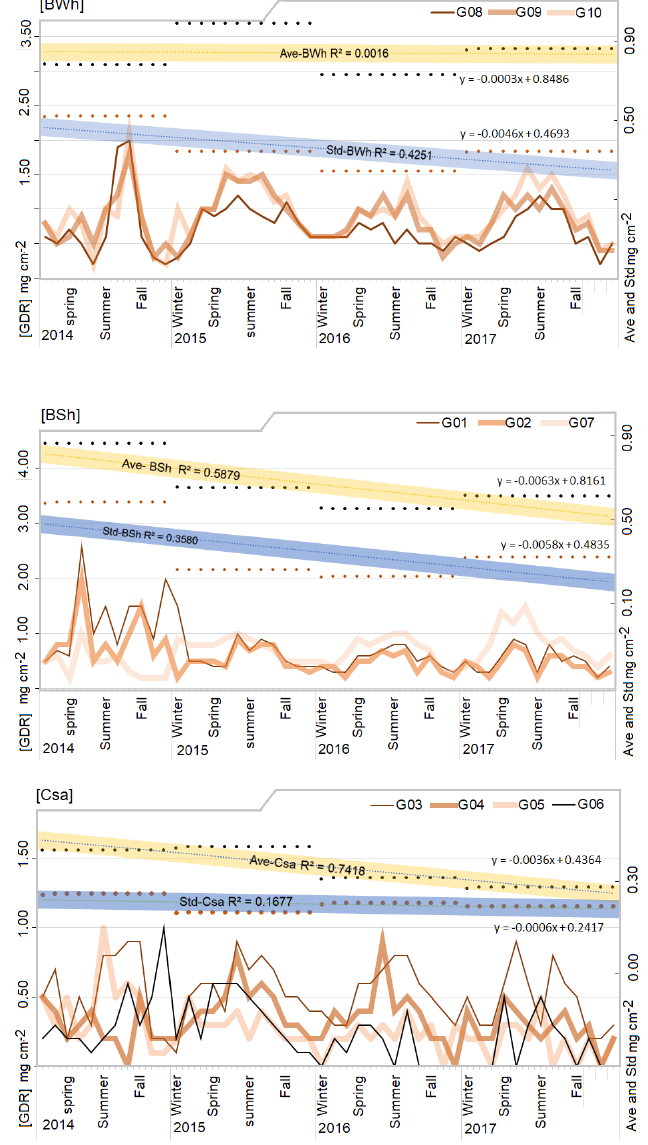
Figure 8. Time series of ground deposition rates (GDRs, mg cm − 2 ). From top to bottom, the GDRs (vertical axis) plot against seasonal pattern (horizontal axis) for sites G08, G09, and G10 from BWh, G01, G02, and G07 from BSh, G03, G04, G05, and G06 from Csa. The GDRs are weighted monthly in mg cm − 2 from data collected onto a plate with a diameter of 20 cm. Dotted lines show average deposition rates (black dotted line) and standard deviation (brown dotted line). Diagonal lines is created for each climate region (BWh, BSh, and CSa) by a linear trend line revealing the overall direction of std and average deposition rates in blue and yellow